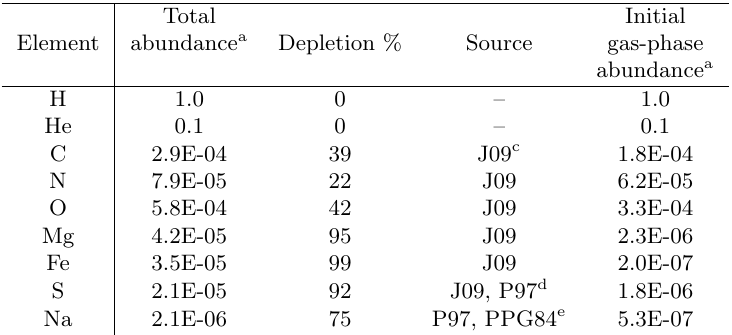
Table 1. The adopted abundances and depletion of elements used in the model. Total Initial Element abundance a Depletion % Source gas-phase abundance a H 1.0 0 { 1.0 He 0.1 0 { 0.1 C 2.9E-04 39 J09 c 1.8E-04 N 7.9E-05 22 J09 6.2E-05 O 5.8E-04 42 J09 3.3E-04 Mg 4.2E-05 95 J09 2.3E-06 Fe 3.5E-05 99 J09 2.0E-07 S 2.1E-05 92 J09, P97 d 1.8E-06 Na 2.1E-06 75 P97, PPG84 e